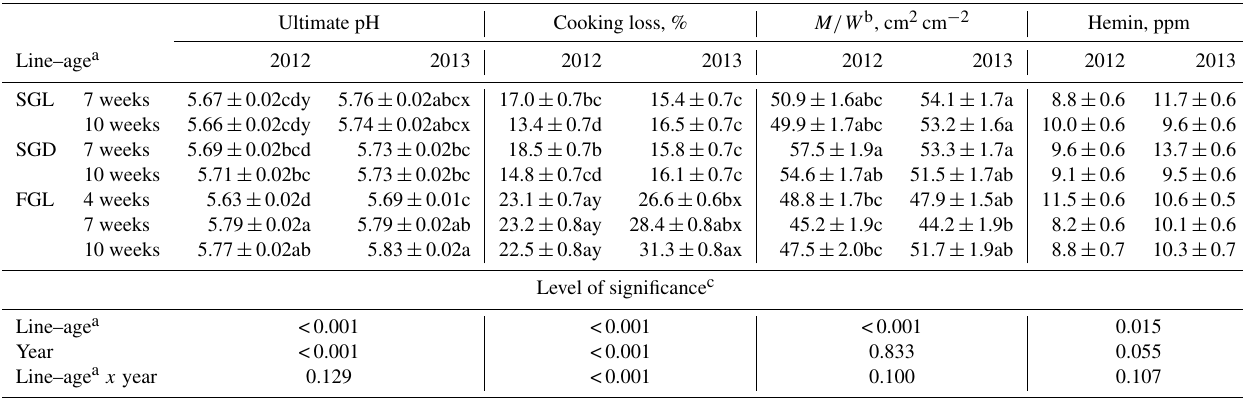
Table 3. Effect of the combination of chicken line, slaughter age, and year on the ultimate pH, water-holding capacity, and pigment concen- tration of breast